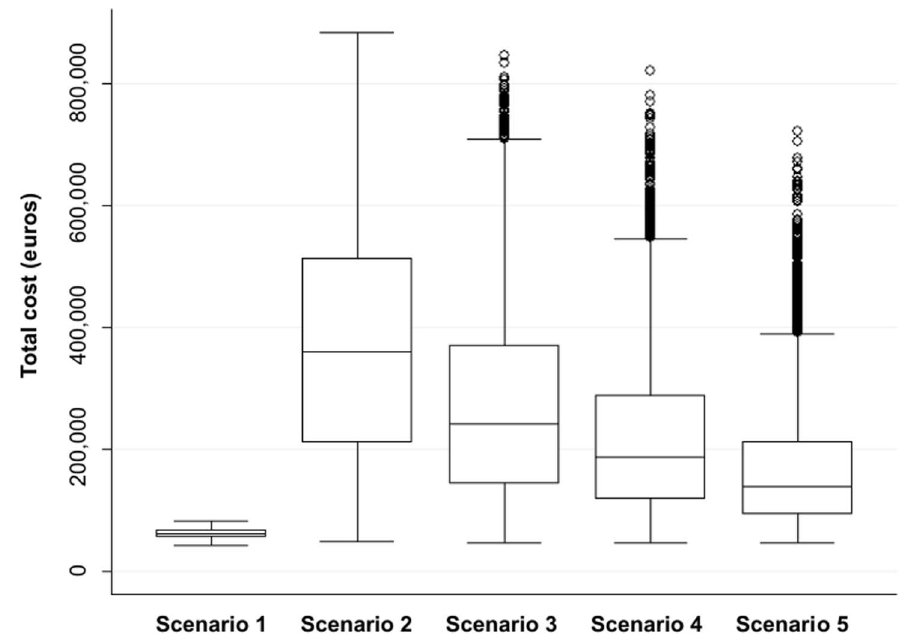
Figure 3. Boxplot representing the estimated total costs of CE in Spain in 2005 under the five scenarios. Legend: Lower line of the box represents the 25th percentile value. Middle line of the box represents the median. High line of the box represents 1.5 the 75th percentile value. The upper whisker represents the 75 th percentile plus 1.5 the interquartile range. The lower whisker represents the 25 th percentile minus 1.5 the interquartile range. The dots over the high lines represent values that lie outside the lower and upper whisker values (outliers).